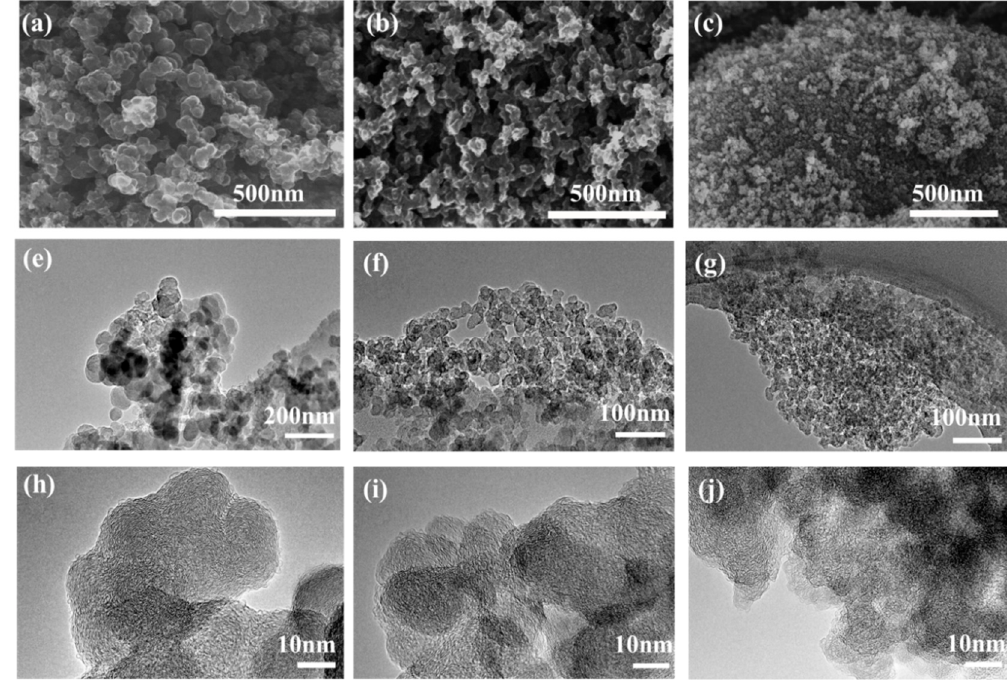
Figure 3. ( a – c ) Scanning electron microscopy (SEM) images, ( e – g ) transmission electron microscopy (TEM) images, ( h – j ) high-resolution TEM (HRTEM) images of CB1, CB2 and CB3,